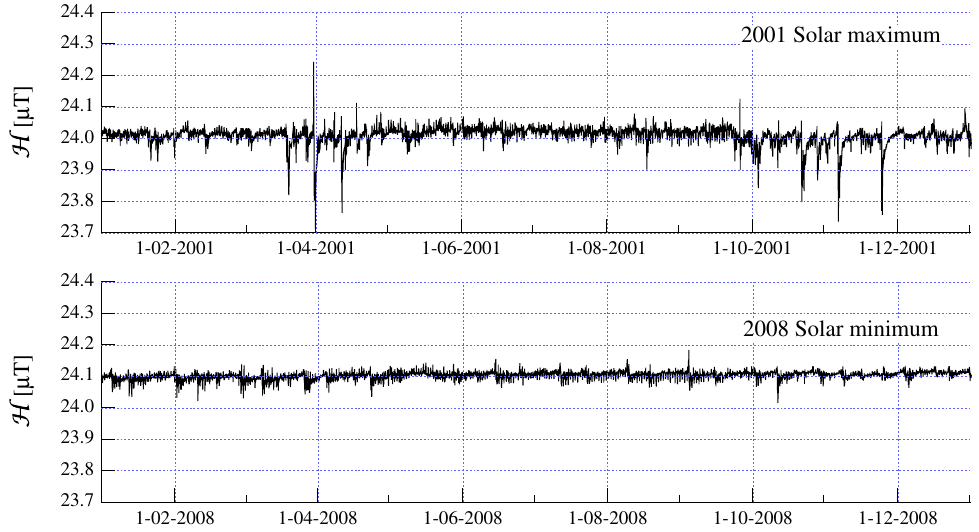
Fig. 6. The geomagnetic field horizontal intensity H , as recorded at L’Aquila Geomagnetic Observatory (Italy) in 2001 (upper panel) and 2008 (lower panel).